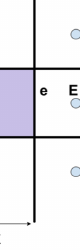
Figure 1. A typical finite volume employed in the